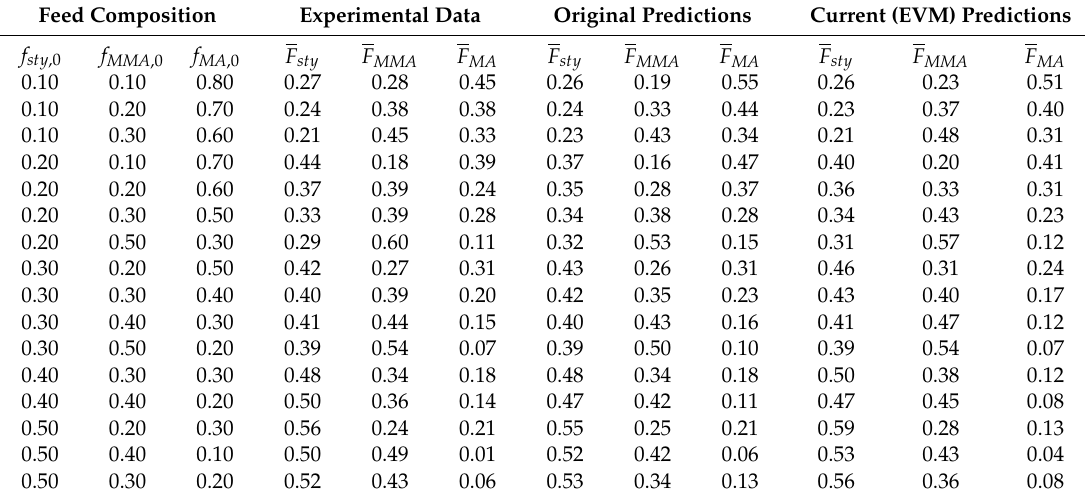
Table 7. Comparison of model predictions for the Sty / MMA / MA terpolymerization. Experimental data and original predictions from [34].